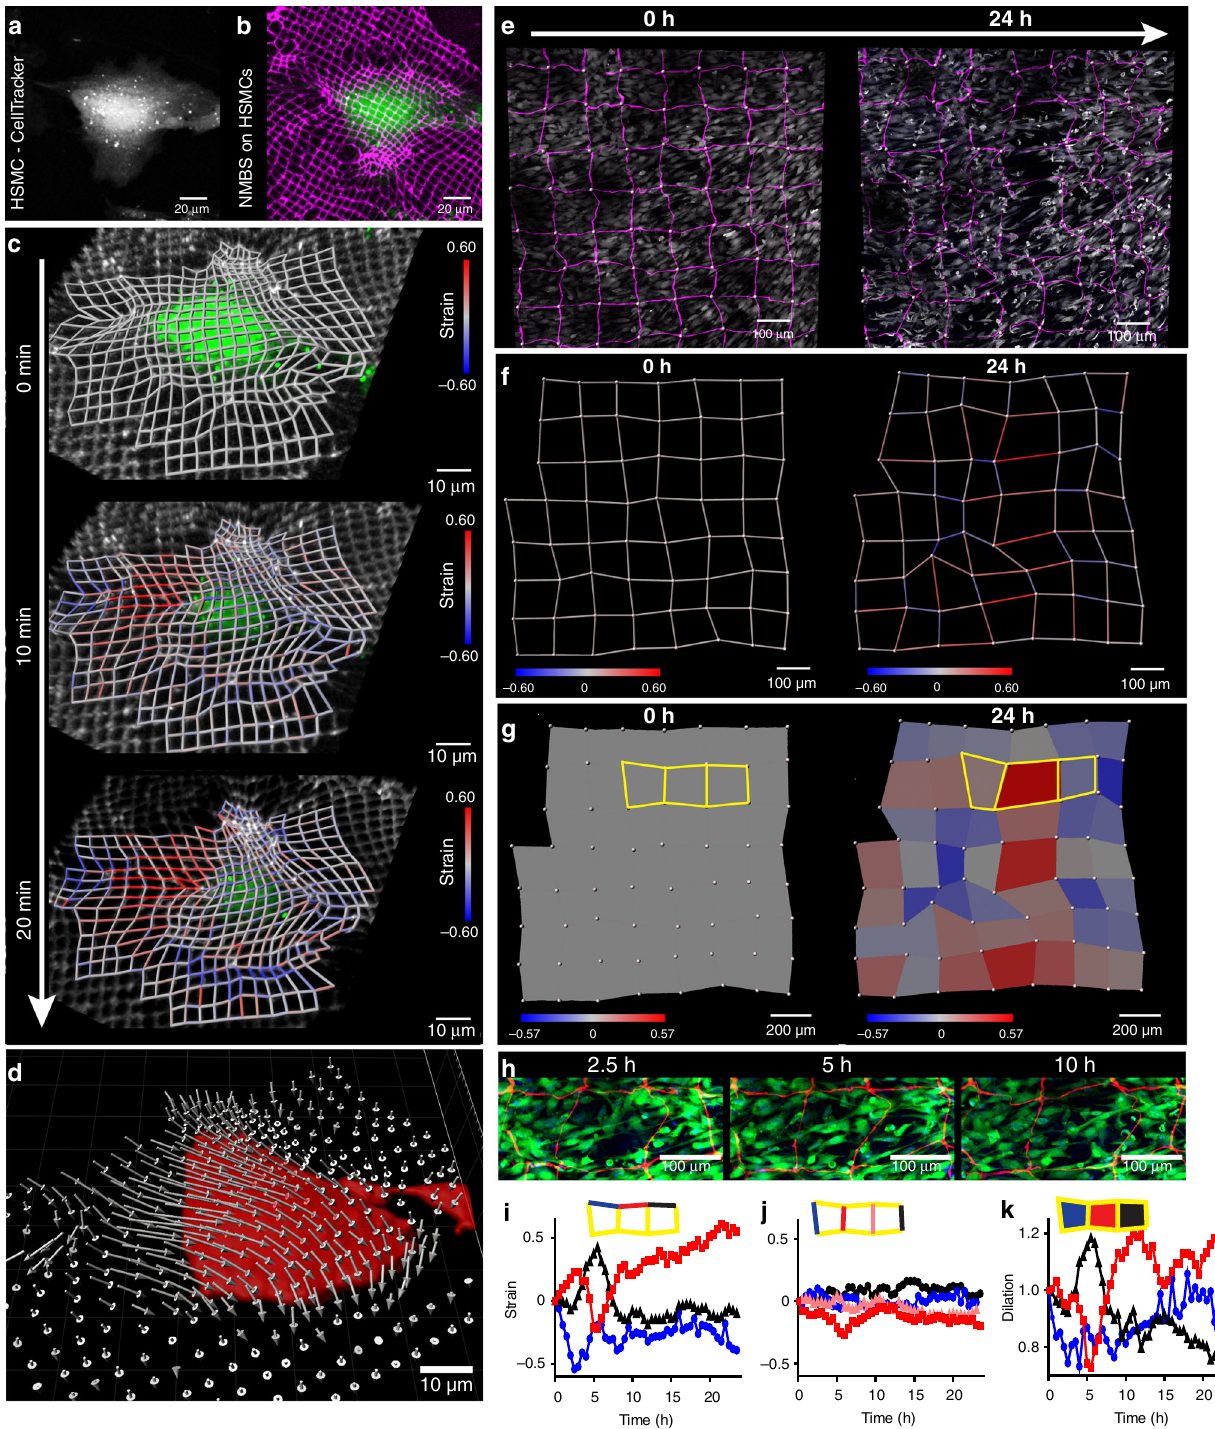
Fig. 3 3D cellular strain mapping with the NMBS. a Human skeletal muscle cells (HSMC) visualized with CellTracker-488. b Alexa-647 fi bronectin NMBS (2 µ m × 2 µ m × 2 µ m, magenta) applied to the HSMC (green). c Mapping of the NMBS strain over time reveals local regions of tension and compression following cell migration and contraction. d 3D displacement vector map (gray arrows) showing the magnitude and direction of displacement for all NMBS mesh nodes as the cell compresses (Red surface) over 20 min. e Alexa-555 fi bronectin NMBS (100 µ m × 100 µ m × 10 µ m, magenta) applied to C2C12 cells visualized with CellTracker-488 (gray). Images were acquired every 30 min for 24 h to track strain following transition to C2C12 differentiation media. f Strain mapping of the NMBS (red = tension, blue = compression) following transition to differentiation media reveals localized regions of tension and compression. g Area dilation was calculated for each section of the NMBS over time and shows spatial regions of expansion and contraction. h Regions of interest extracted showing cellular elongation events at 2.5, 5, and 10 h following transition to differentiation media (NMBS, red; C2C12 cells, green). i , j Quanti fi cation of segments from the region of interest in “ g ” during the C2C12 differentiation process shows region-speci fi c strain rates during the 24-h time course, with the largest magnitude strains occurring in the x-direction. k Time-dependent mapping of regional dilation during the C2C12 differentiation process for ROI analyzed in ( i , j